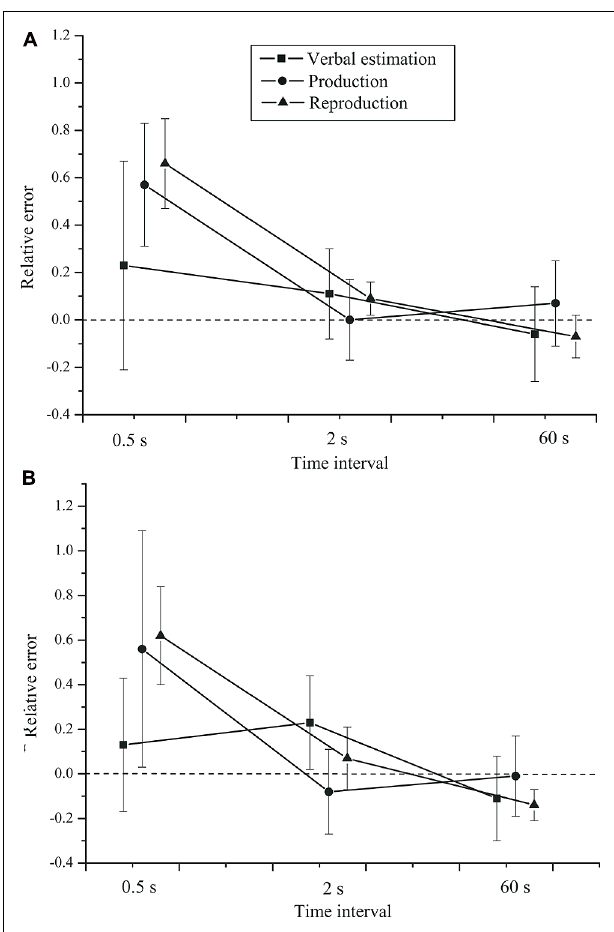
FIGURE 2 | Mean relative error as a function of time interval, task, and group. (A) Control group. (B) Depressive patients. Error bars: 95% CIs.